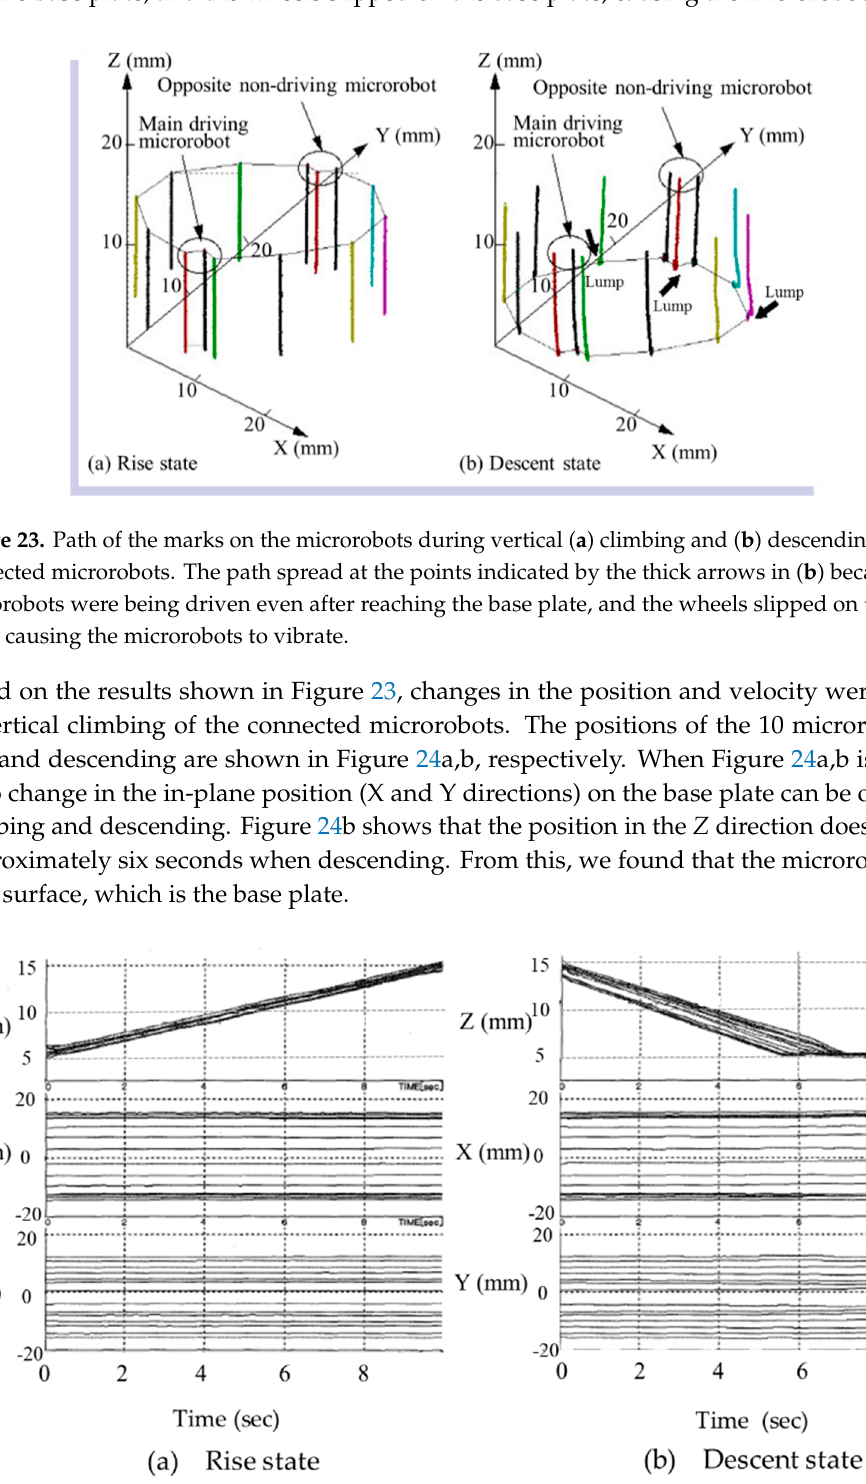
Figure 24. Measurement results of the position of the 10 microrobots when ( a ) rising and ( b ) descending. The X -axis represents the tangential direction, the Y -axis represents the radial direction, and the Z -axis represents the axial direction of the cylinder. There was almost no change in the in-plane position (X and Y directions) on the base plate, for both climbing and descending. From ( b ), the position of the Z-direction does not change after approximately six seconds when